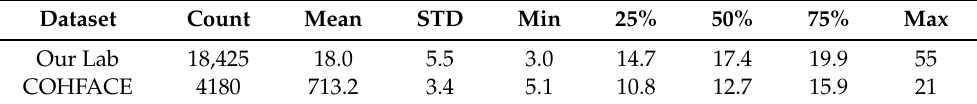
Figure 4. Histogram ( a ) and box plot ( b ) of BR engineered datasets from the extracted green-channel AC-component data. Table 2. Statistical Summary of the BR Engineered Datasets Based on the Extracted Green-Channel